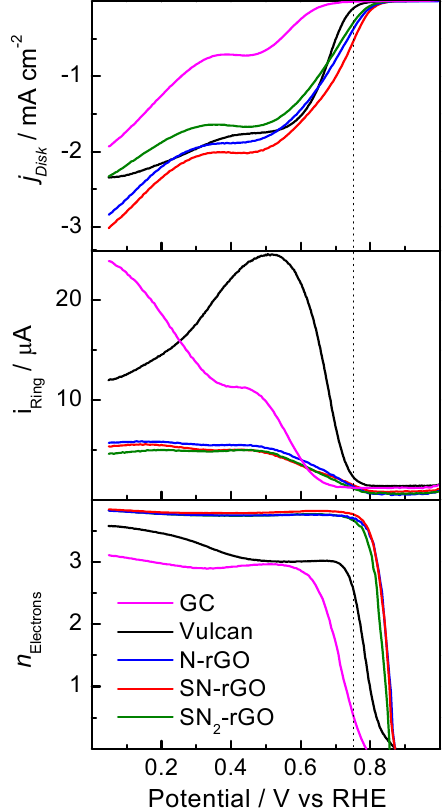
Figure 6. Steady-state polarization curves for O 2 reduction at 1600 rpm in 0.1 M NaOH at 25 ◦ C for all employed electrocatalysts ( top panel ); faradaic currents developed at 1.2 V at the Pt ring electrode ( middle panel ); number of electrons transferred ( n ) during the oxygen reduction reaction (ORR; bottom panel ). Sweep rate of 0.002 V s − 1